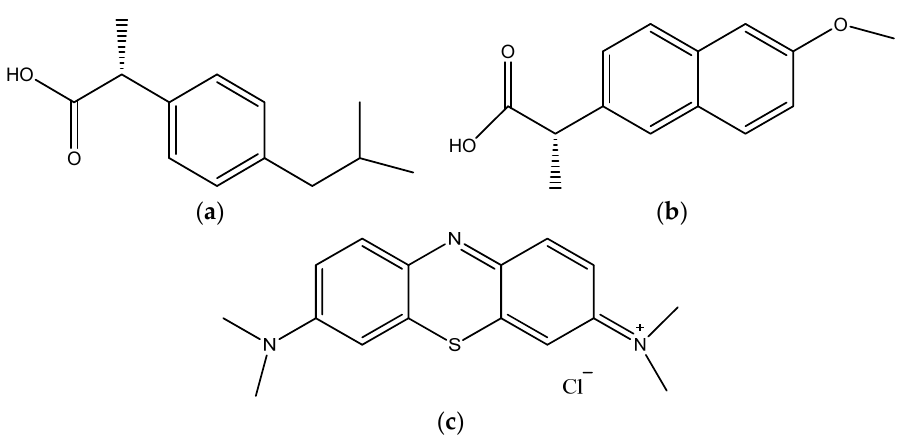
Figure 1. ( a ) Ibuprofen; ( b ) Naproxen; ( c ) Methylene blue